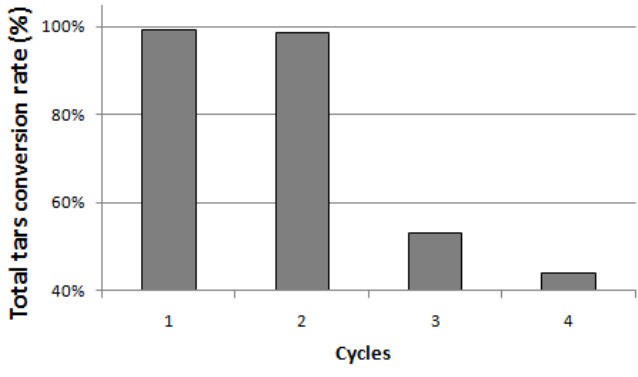
Figure 4. Total TARs conversion rates during the cycles.